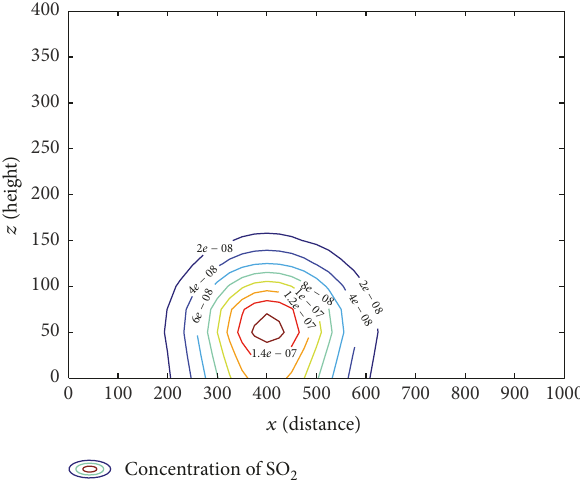
Figure 7: The concentration levels of air pollution after 1 hour and 36 minutes have passed which are controlled by air quality standard ( 3 × 10 −7 kg/m 3 ).